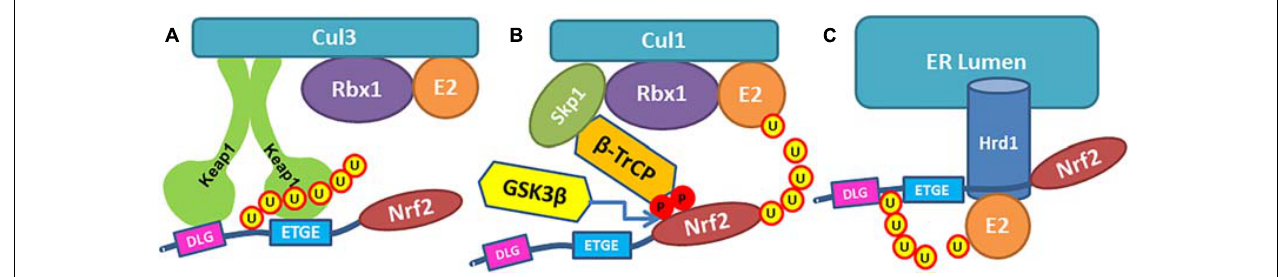
FIGURE 1 | Three pathways of Nrf2 ubiquitinylation. (A) Nrf2 Neh2-domain is recognized by Keap1 dimer and binds Keap1 Kelch domains via ETGE and DLG binding motifs, so the lysine residues in Neh2 are ubiquitinylated by Cullin3 ligase. (B) β -TrCP in Cul1 ubiquitin ligase complex binds Neh6 domain in Nrf2 protein via DSAPGS and GSK3 β - phosphorylated DSGIS binding motifs, so Nrf2 is getting ubiquitinylated. (C) Ubiquitin ligase Hrd1 ubiquitinylates Nrf2.